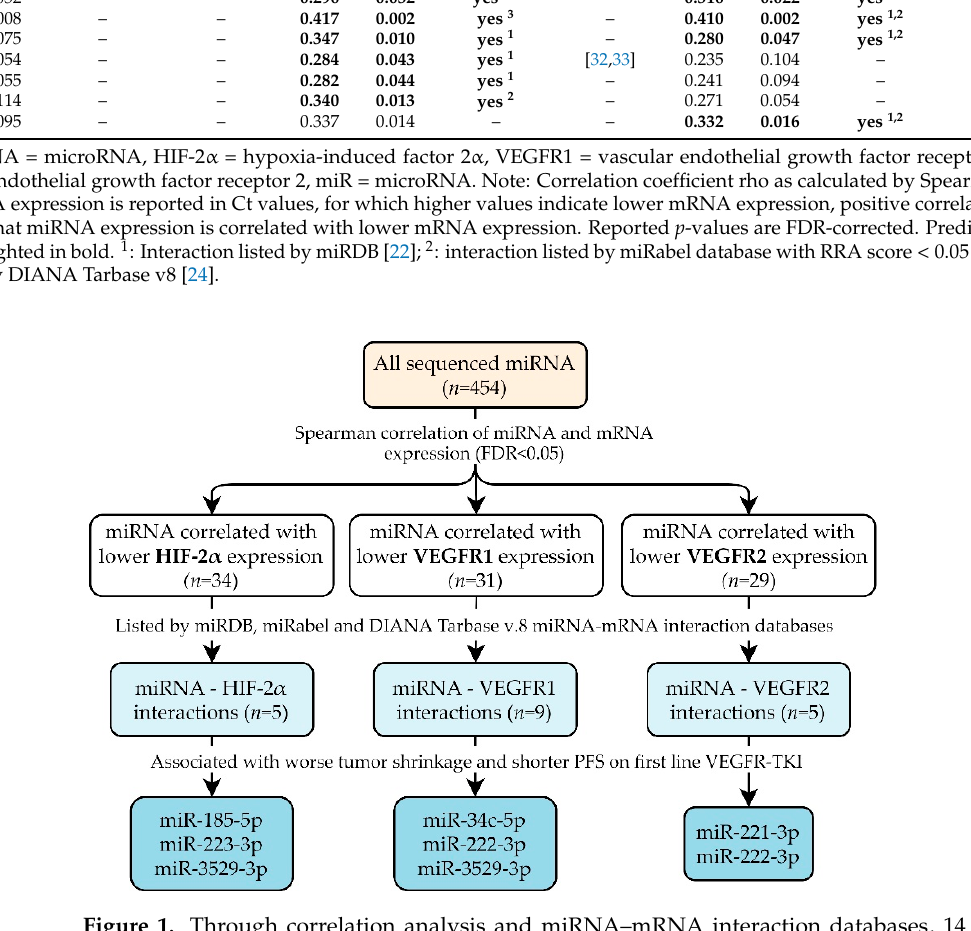
Table 2. miRNAs inversely correlated with HIF-2 α , VEGFR1 or VEGFR2 expression and listed by miRNA–mRNA interaction databases.